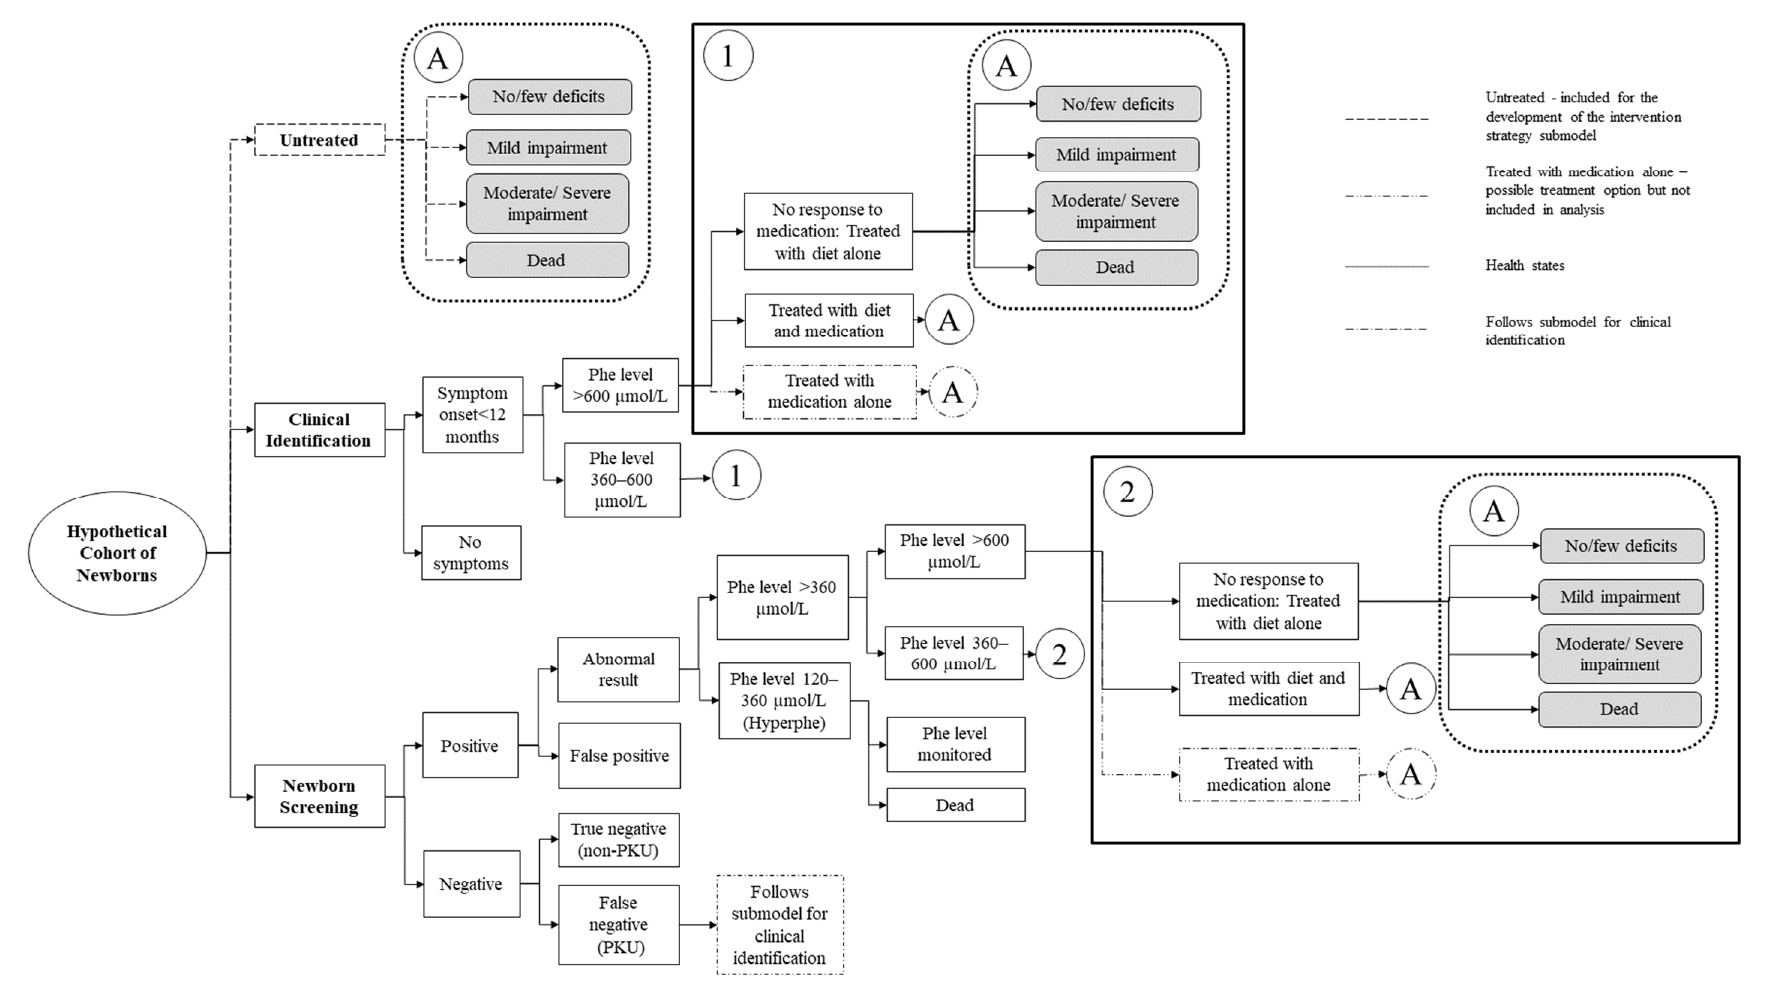
Figure 1. Model Figure 1. Model framework.